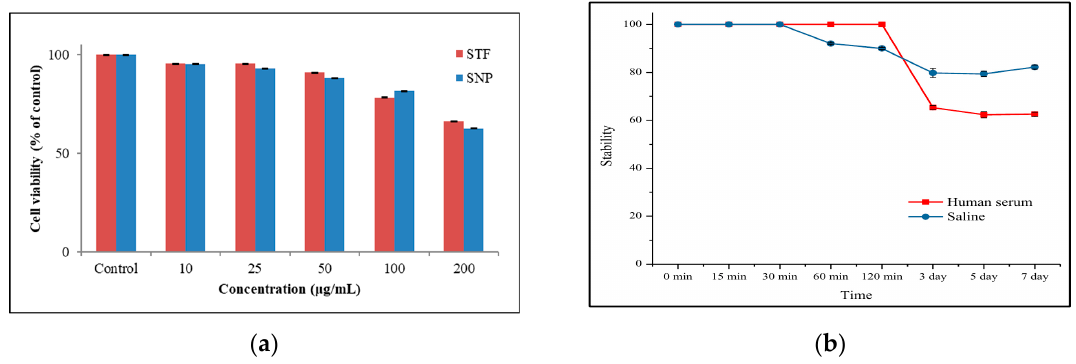
Figure 4. ( a ) The cytotoxicity study using STF and SNP was conducted on CT-26 for 24 hours and ( b ) In-vitro stability evaluation of 89 Zr-STF: Stability in human serum and saline was monitored by radio TLC. The 89 Zr -STF was incubated with 1.0 mL of human serum and saline at 37 °C for 7 days and then analyzed.